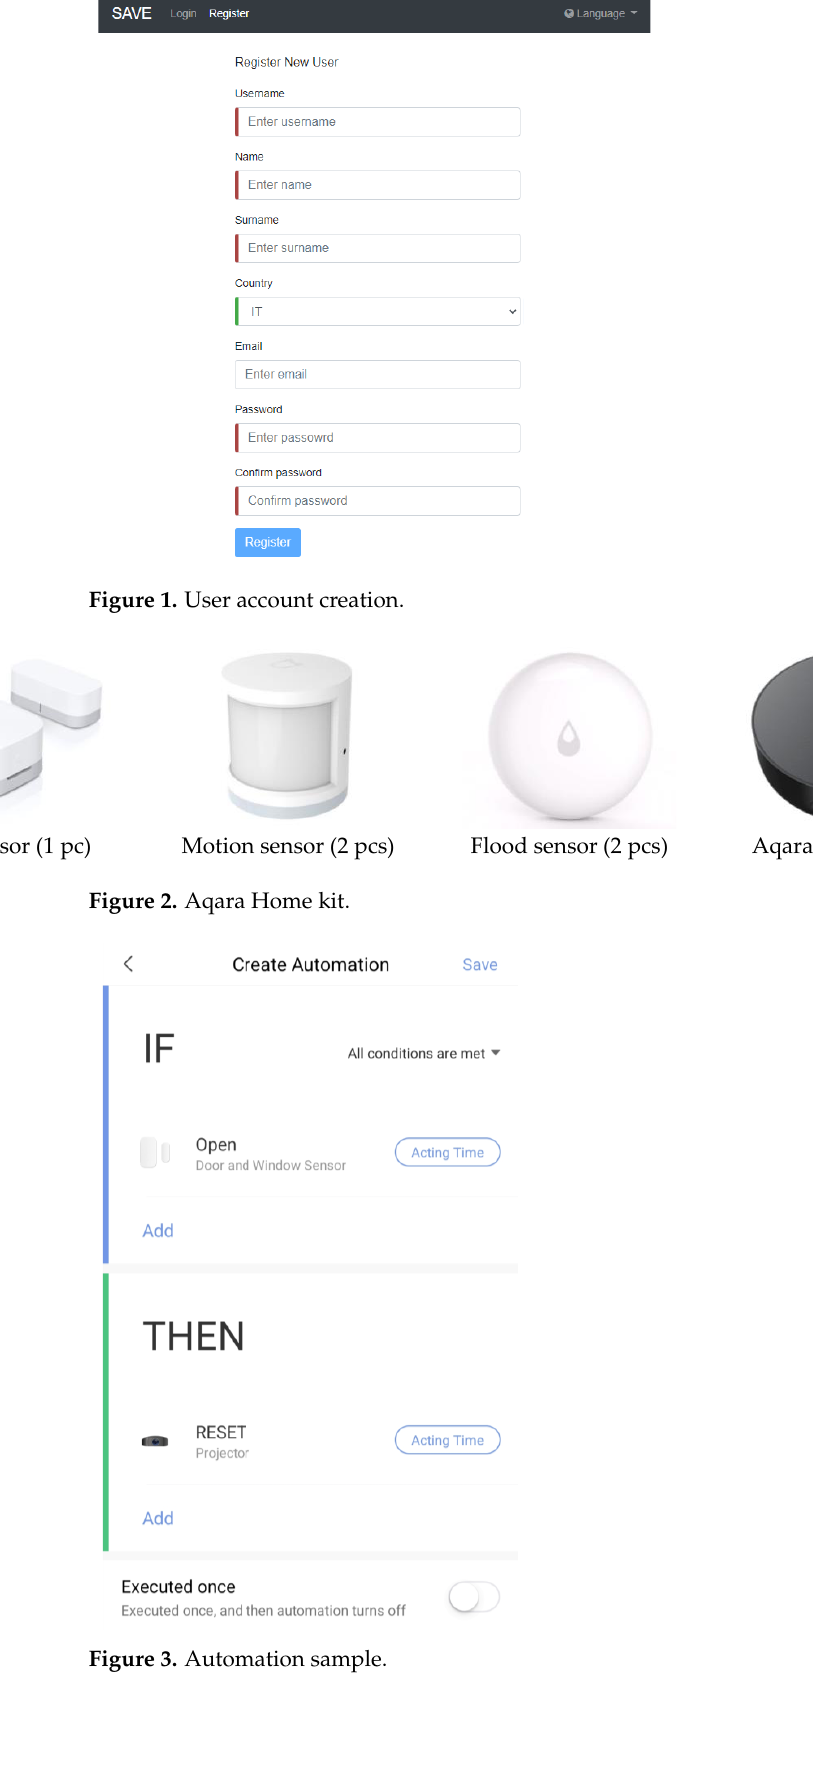
Figure 4. SAVE sensors adapter.